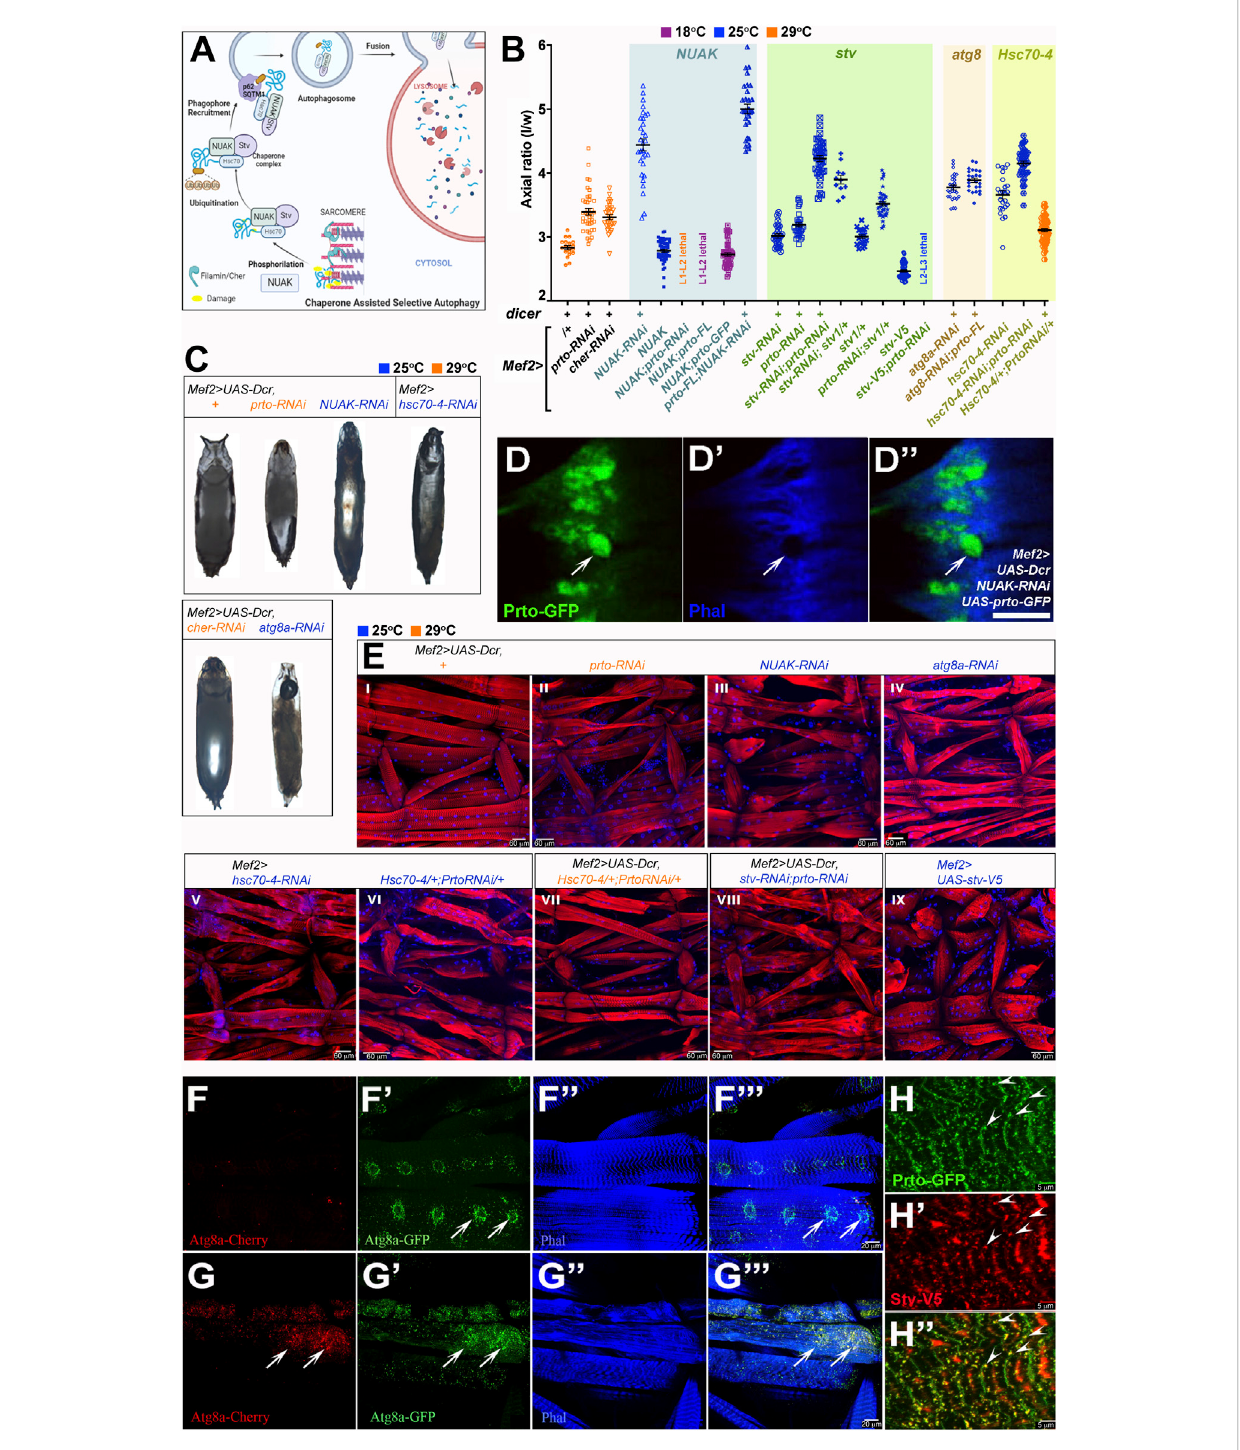
FIGURE 5 prto interacts genetically with CASA pathway for maintaining sarcomeric integrity. (A) Model for Chaperone Assisted Selective Autophagy (CASA) of Filamin/CherinmusclesconstructedusingBiorender.com.Filamindimersmaintainmusclesarcomericstructureundergoingsustainedcontractileforces during locomotion. Damaged Filamins (yellow) are phosphorylated by NUAK kinases and recruits Stv-Hsc70-4 protein complex for refolding. Unrepairably damaged Filamins are ubiquitinated and subsequently recruited by the p62/SQSTM1 complex and Atg8a to initiate autophagosome formation. Autophagosomes fuse with lysosomes for degradation of damage Filamin/CASA complexes. (B) Axial ratio measurements of prto and CASA RNAi KD genotypes and genetic interactions. Genotypes denoted in the x-axis and grouped by gene interaction each with a distinct background colour. All + and RNAi genotypes are driven with Mef2 > without or with Dicer the latter denoted as (+) above genotypes. Temperature conditions for each